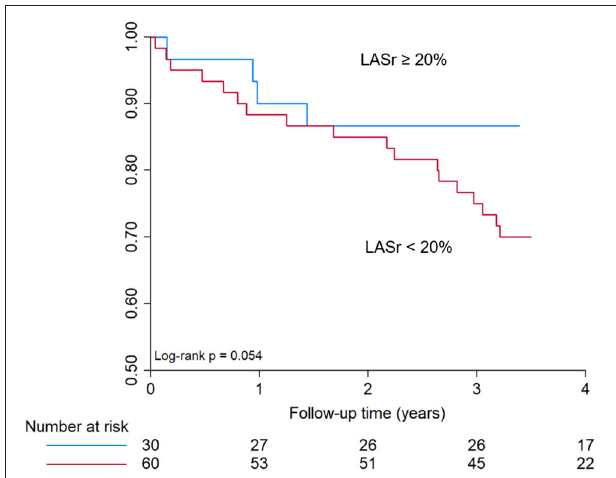
FIGURE 4 | Kaplan-Meier curve for all-cause mortality in patients with < 20% or ≥ 20% LASr. Kaplan–Meier curve shows only a trend toward reduced survival in patients with severely reduced LASr at baseline ( < 20%), however no significant difference was observed during a mean follow-up time of 3.4 ± 1.3 years. LASr, Left atrial peak reservoir